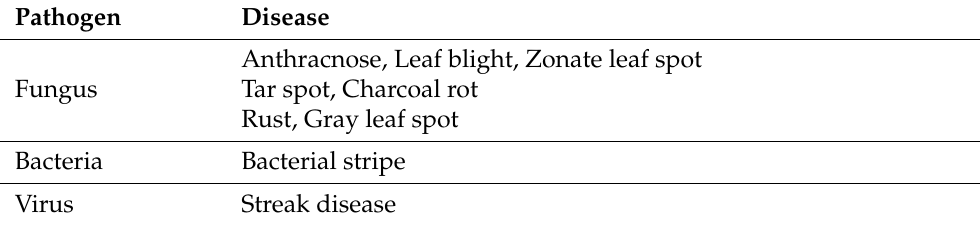
Table 6. Some Sorghum disease types and causing pathogens [20,43].